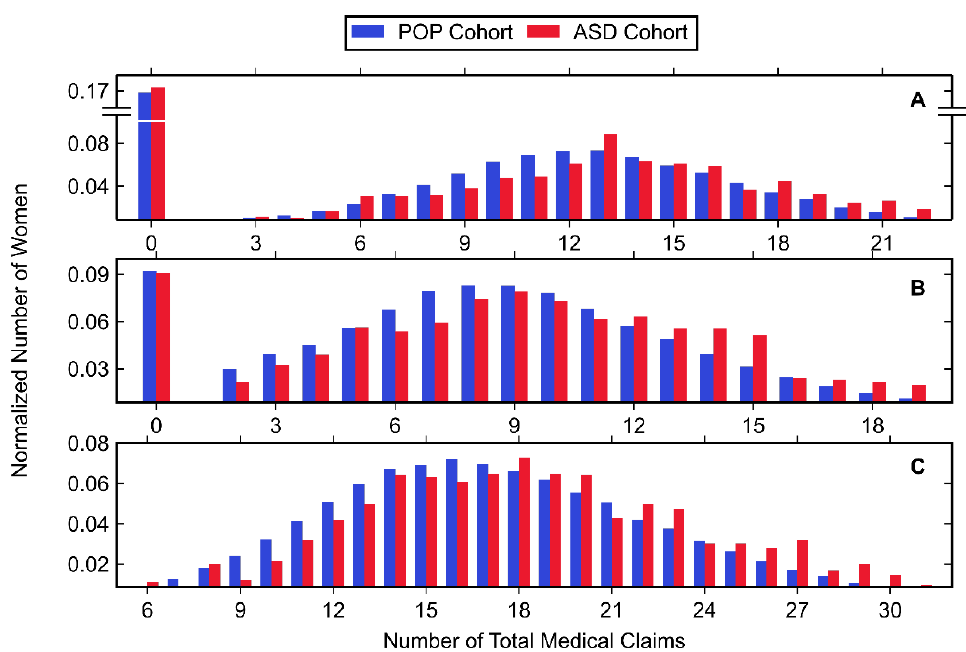
Figure 3. Histogram data of normalized number of women belonging to the POP and ASD cohorts (shown in blue and red, respectively) with any medical claim during the ( A ) first trimester, ( B ) second trimester, and ( C ) third trimester. Values associated with small cell sizes are not shown in order to be compliant with OptumLabs’ de-identification policy. Table 6. Statistics of Number of Medical Claims during Each